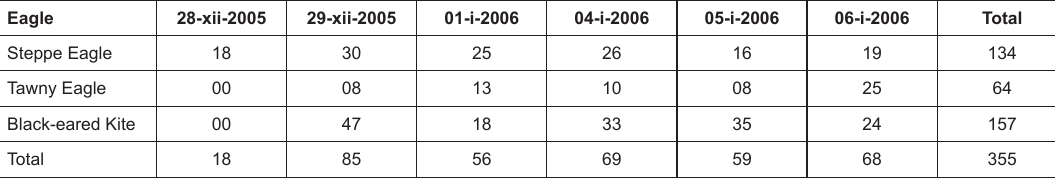
Table 1. Daily migration pattern of raptors in December-January